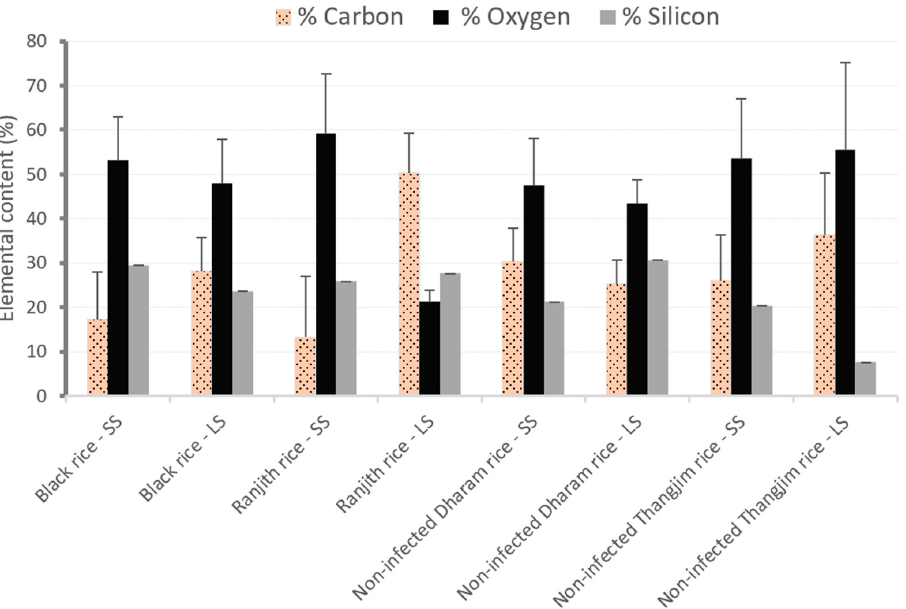
Figure 6. Relative distribution of carbon, oxygen, and silicon in long spikes (LS) and small spikes (SS) region in different rice varieties. Bar represents standard errors.